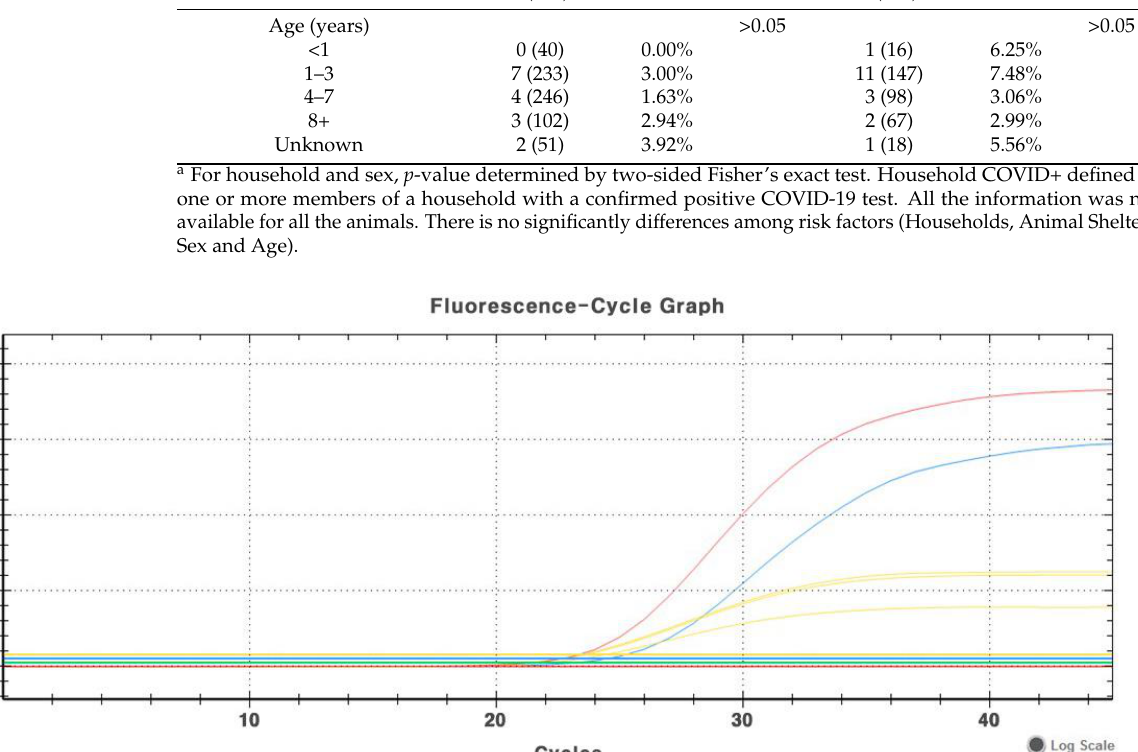
Figure A1. Real-time qPCR amplification curves of SARS-CoV-2 in positive control, negative control and negative sample. Amplification curves were produced from N gene ([red line, Ct = 23.30]) and ORF3a gene ([blue line, Ct = 24.47]) of SARS-CoV-2-positive control and the other amplification curves (yellow line) displayed IPC of positive control (Ct = 22.16), negative control (Ct = 21.43) and negative sample (Ct = 21.34), respectively.